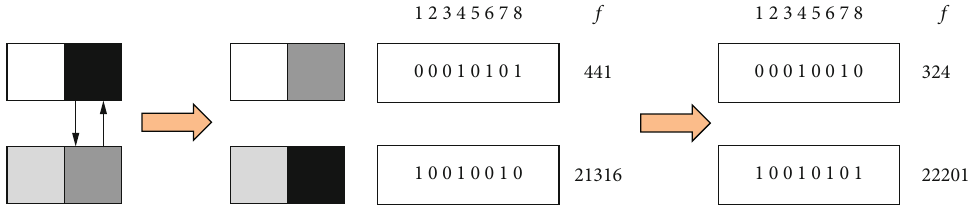
Figure 3: One-point intersection example.